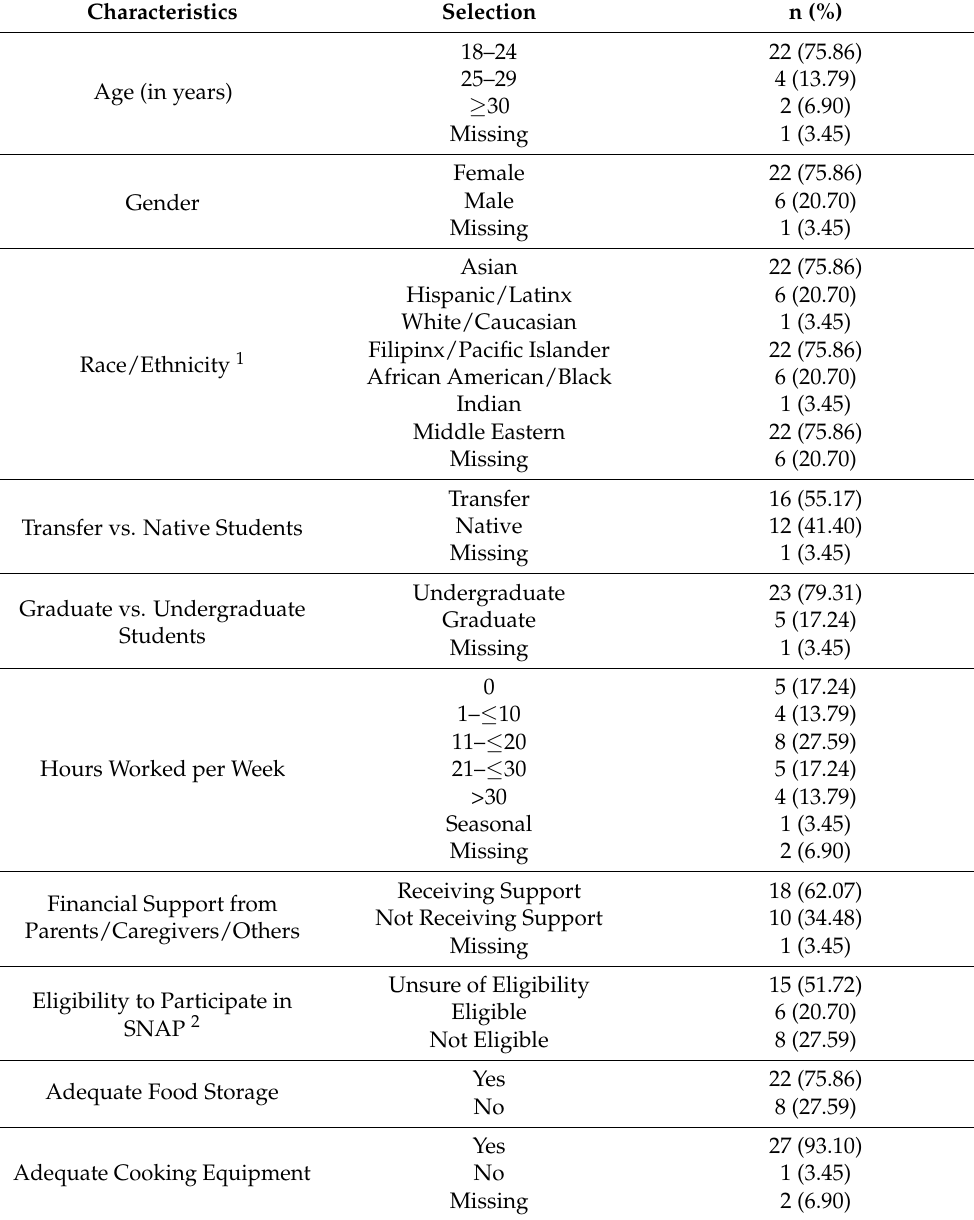
Table 1. Characteristics of marginally food-secure students as California State University, East Bay (n =